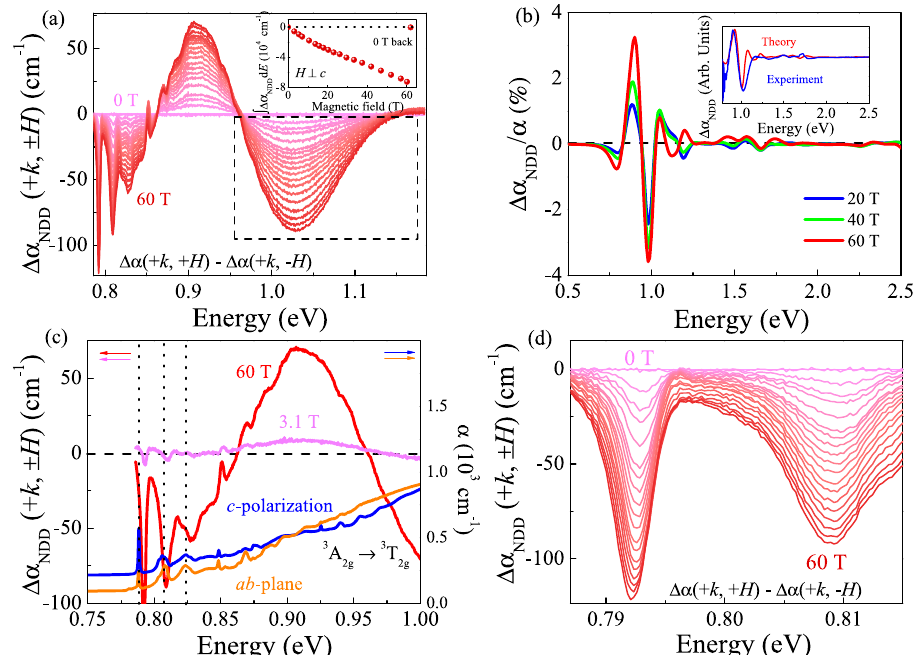
Fig. 3 Nonreciprocity in the toroidal geometry. a Nonreciprocal directional dichroism of Ni 3 TeO 6 in the toroidal con fi guration measured between 0 and 60 T at 4.0 K. The inset is the integration of the indicated feature in the dashed box over an appropriate energy window. No hysteresis is observed. b Simulated nonreciprocal directional dichroism of Ni 3 TeO 6 in the toroidal con fi guration. The inset shows a comparison of the calculated and measured results at 60 T. The intensity is normalized to the maximum of Δ α NDD . c Close-up view of Δ α NDD at 3.1 and 60 T compared with the linear absorption spectrum. d Close-up view of Δ α NDD as a function of fi eld between 0 and 60 T. The complete list of magnetic fi elds in panels ( a ) and ( d ) is: 0, 3.1, 5.5, 7.2, 10.7, 13.8, 15.8, 17.9, 20.3, 23.1, 26.1, 29.6, 33.3, 37.5, 42.1, 47.0, 52.1, 57.1, 60.2